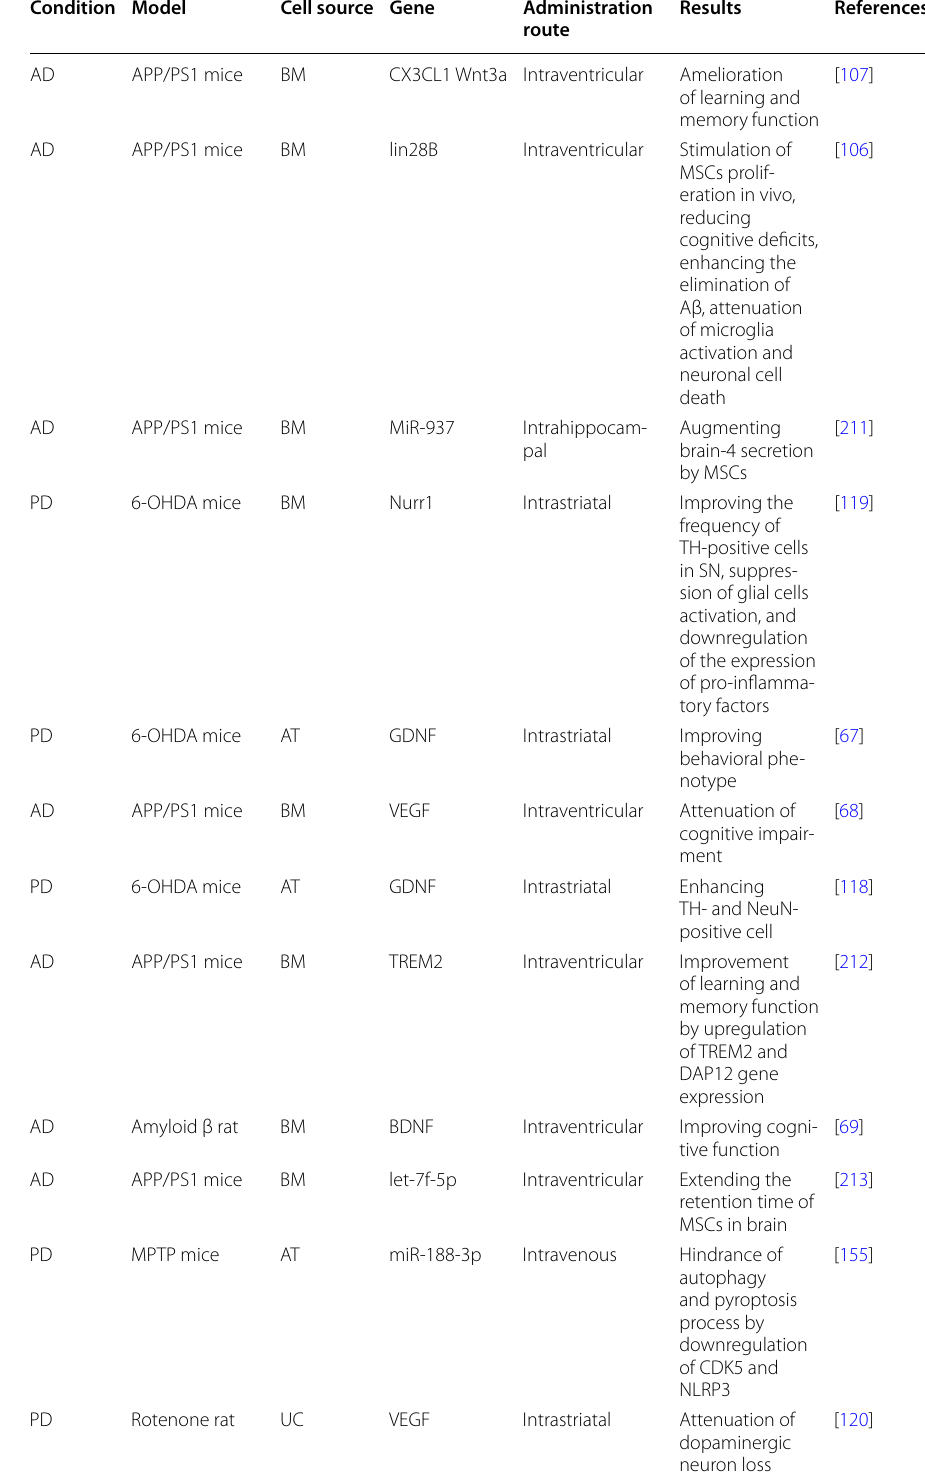
Table 2 Genetically modified MSC therapy in preclinical models of common neurodegenerative